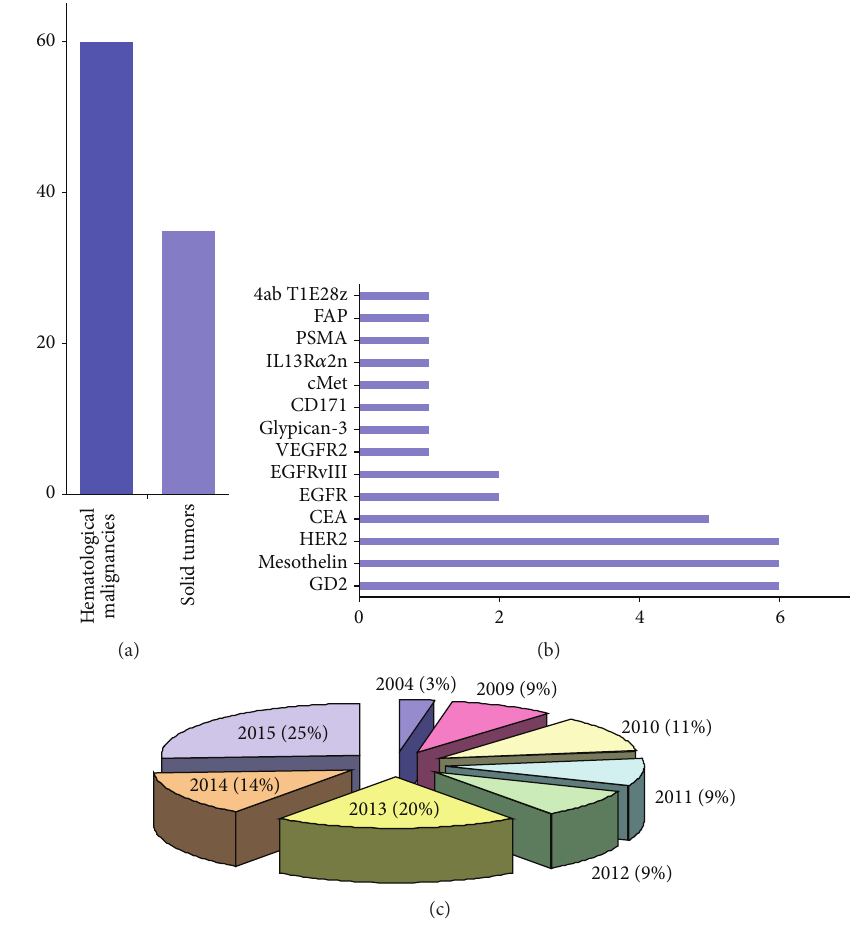
Figure 1: Current status of clinical trials of chimeric antigen receptor-modified T (CART) cells in malignancies. These data were searched on 15 June, 2015, from the website ClinicalTrials.gov (http://www.clinicaltrials.gov). The key phrases “chimeric antigen receptor-modified T cells”, “chimeric antigen receptor”, “CART”, and “CAR” were used. (a) Comparison of the number of registered CART-cell trials for solid tumors and hematological malignancies on the ClinicalTrials.gov website. (b) The registered solid tumor targets for CART cells on the ClinicalTrials.gov website. EGFR: epidermal growth factor receptor; FAP: fibroblast activation protein; PSMA: prostate-specific membrane antigen; VEGFR2: vascular endothelial growth factor receptor 2. (c) Proportion of annual registered numbers of CART cells in solid tumors on the ClinicalTrials.gov